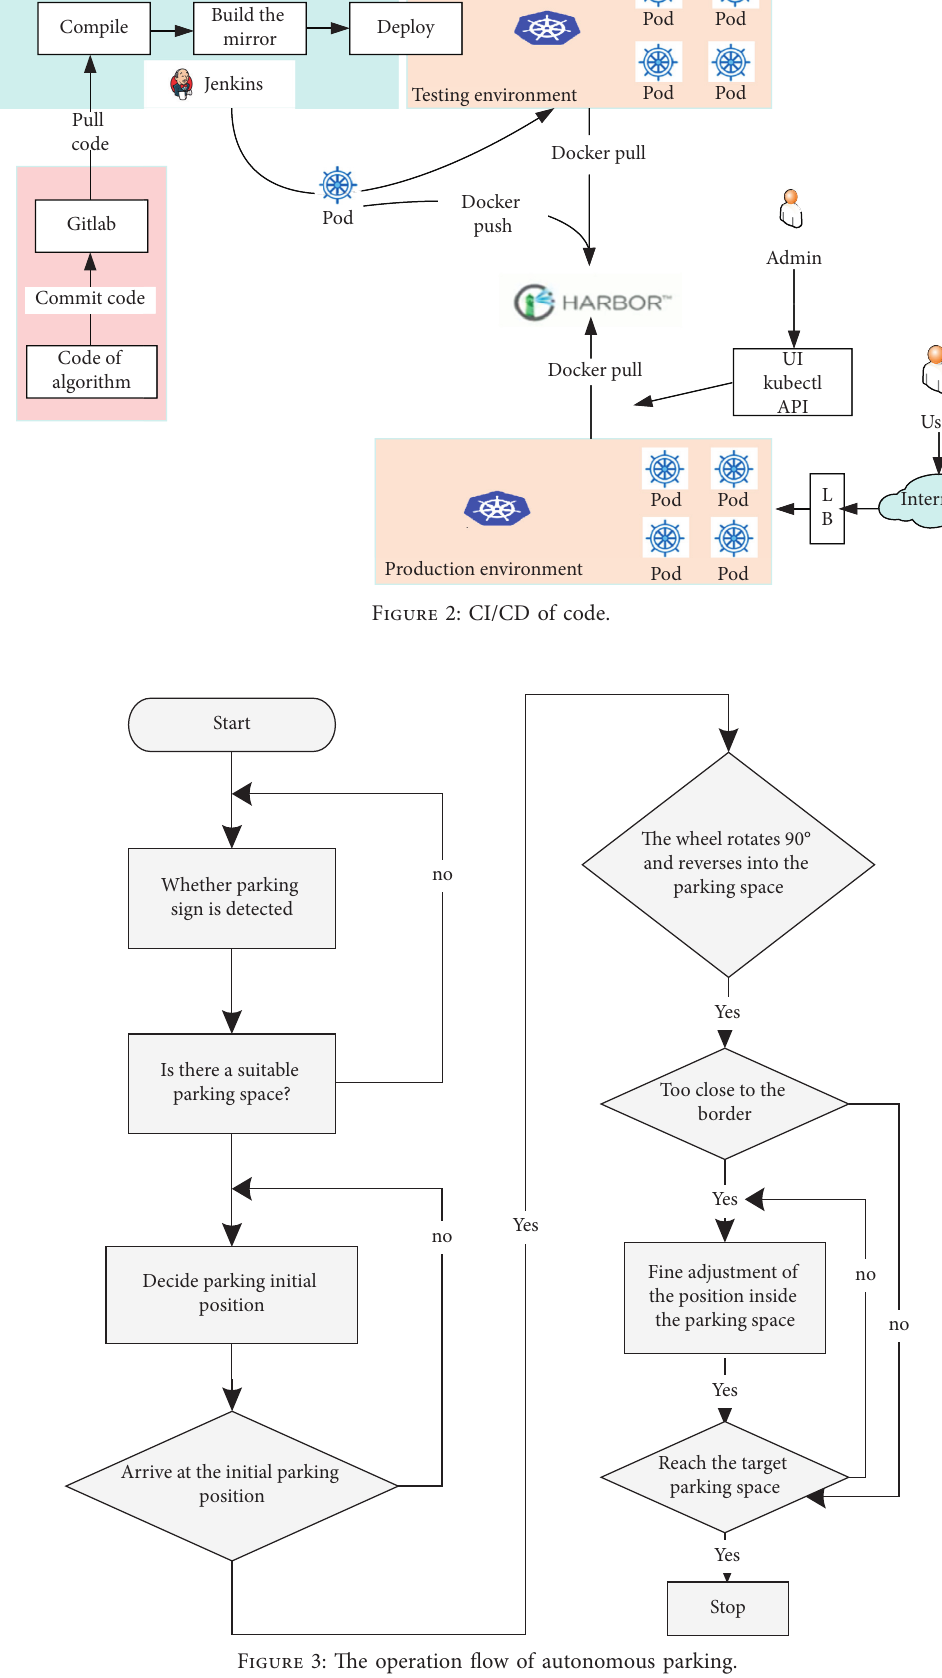
Figure 3: The operation flow of autonomous parking.